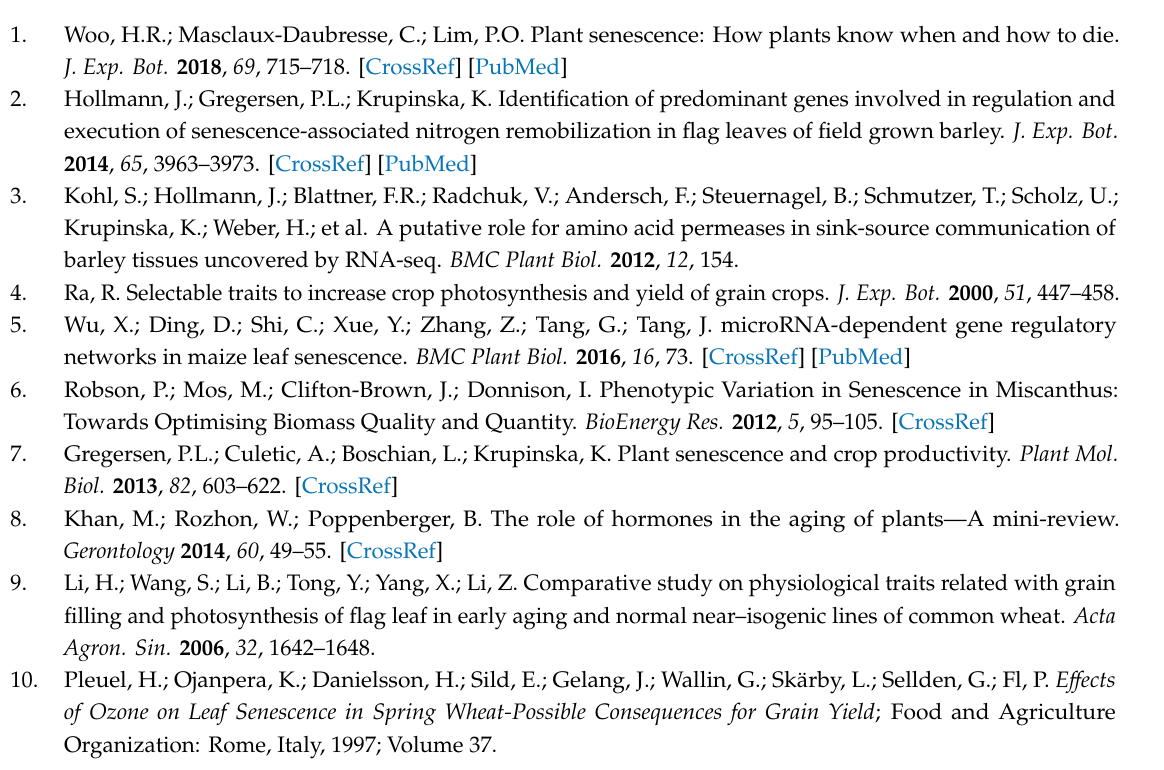
Figure S1: Di ff erent molecular function connect network; Figure S2: RNA-seq and RT-qPCR; Table S1: The detailed information of raw reads from di ff erent samples; Table S2: RT-qPCR primer information; Table S3: Results of transcription factor enrichment analysis; Table S4: Significant di ff erences in DEGs, and DEGs involved in important